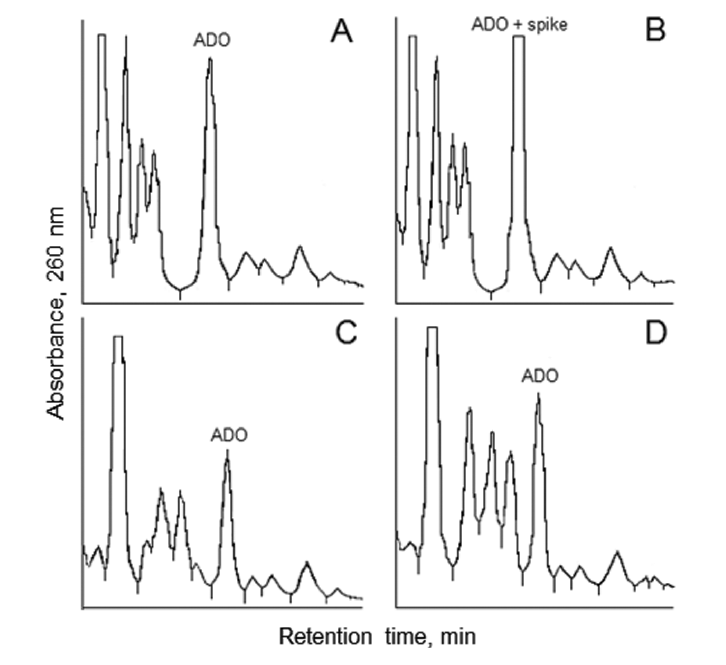
Figure 1. ADO levels in BM plasma obtained from asymptomatic MGUS/SMM and symp- tomatic MM patients. BM plasma samples were analyzed by HPLC. (A) HPLC profile of a representative MM patient (X.I. = 210.84 µ M). (B) ADO confirmed by specific standard spiking (50 µ mol/L) in the BM aspirate from a MM patient (X.I). (C–D) Representative ADO HPLC profiles from one patient with MGUS (C) and one with SMM